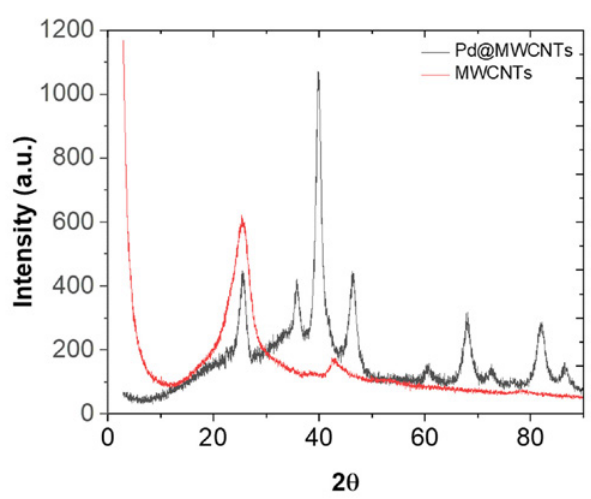
Fig. 4. XRD spectrum of MWCNTs and Pd supported